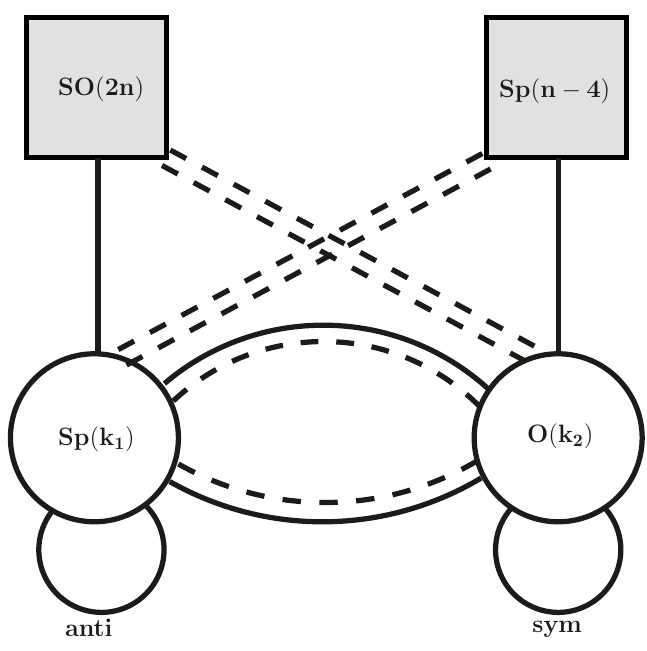
Figure 4 . Quiver for one instanton on D n